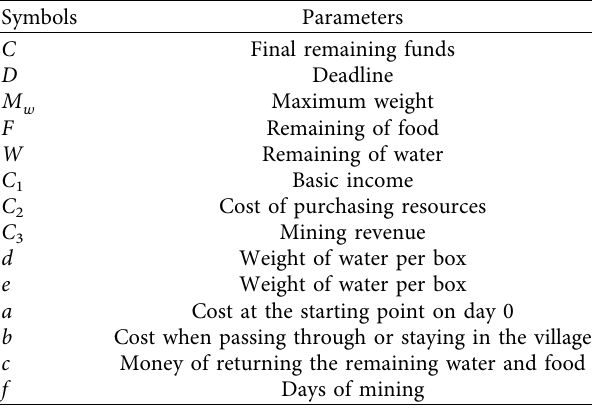
Table 1: Notations.